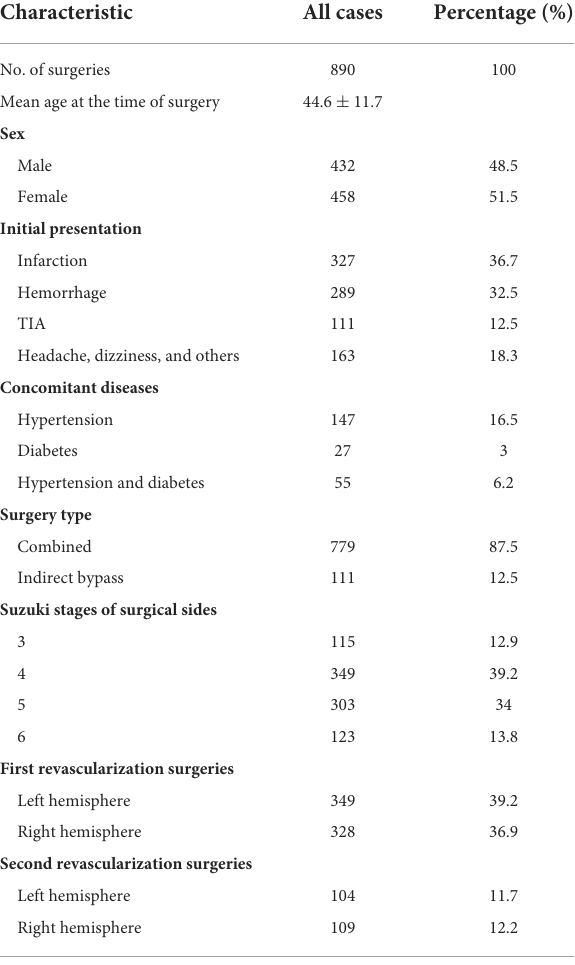
TABLE 1 Baseline characteristics of the included